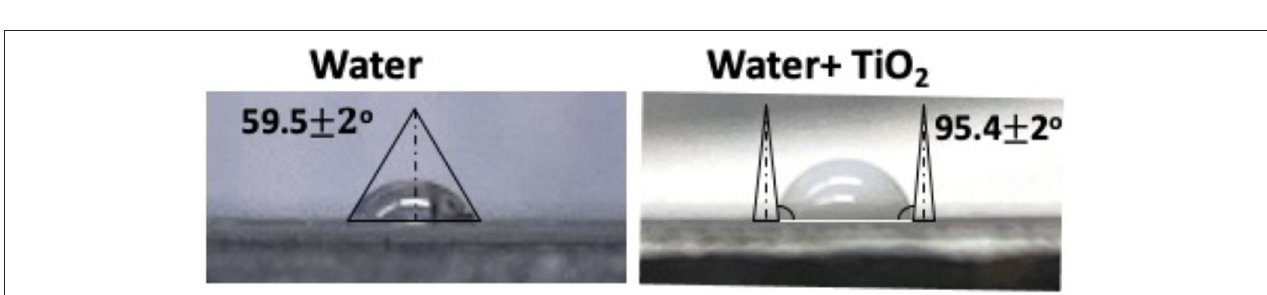
FIGURE 3 | Images of sessile droplets of (left) pure DI water, and (right) a 0.67 wt% suspension of TiO 2 NP atop the QCM 304SS electrode, along with droplet tangents drawn to compute the contact